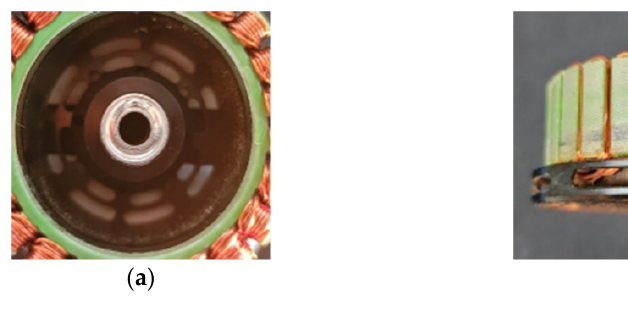
Figure 2. Configuration of collecting time series vibration data.